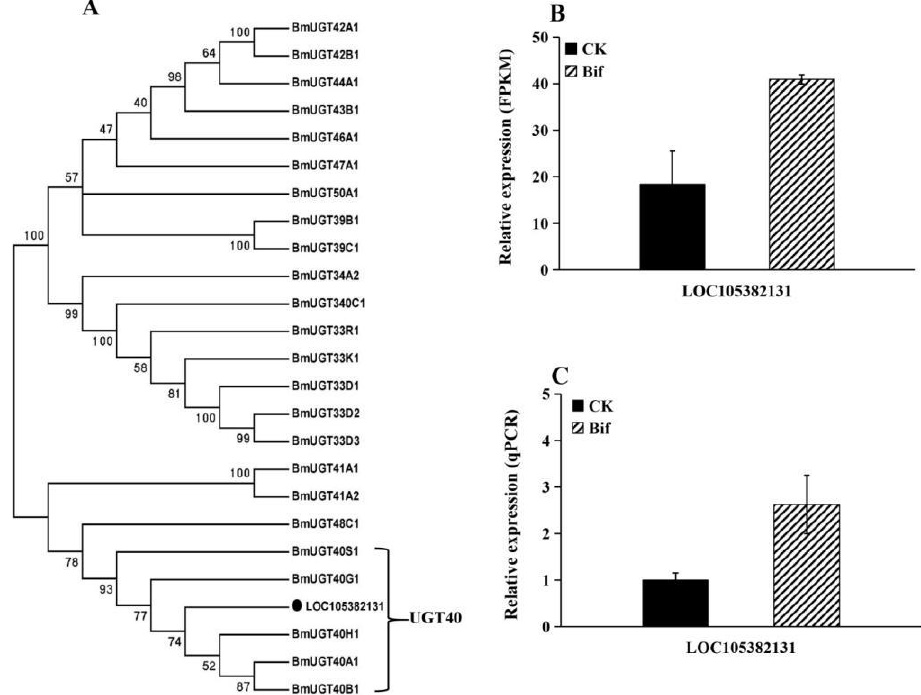
Figure 6. ( A ) Phylogenetic relationships of UGTs from Plutella xylostella (black circle) and Bombyx mori . ( B ) Expression profiles (FPKM value) of a UGT in P. xylostella . ( C ) Expression profiles of a UGT in P. xylostella by qRT-PCR.